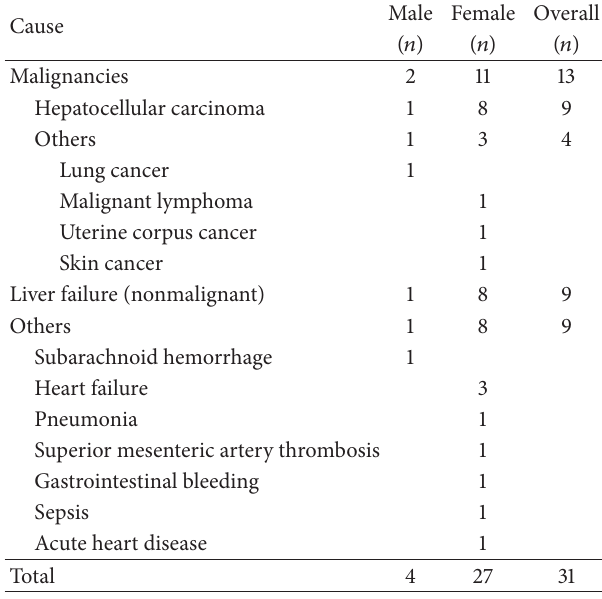
Table 3: Standardized incidence ratio (SIR) and standardized mor- tality ratio (SMR) of HCC in primary biliary cirrhosis.